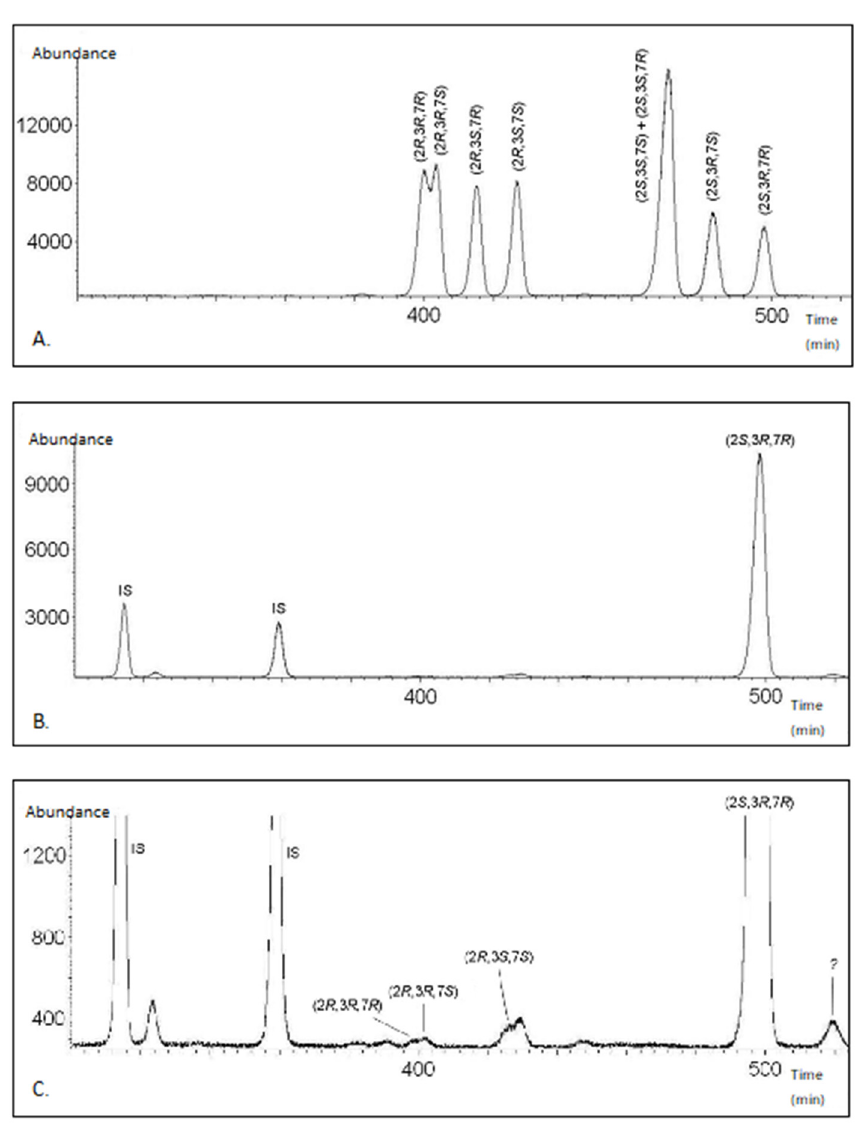
Figure 1. ( A ) GC–MS chromatogram of a reference sample of all the stereoisomers of 3,7- dimethylpentadecan-2-ol after derivatisation with ( S )-2-acetoxypropanoyl chloride. ( B ) GC–MS chromatogram of the purified extract of Diprion similis females after derivatisation with ( S )-2-acetoxypropanoyl chloride. IS = Internal Standard (pentadecan-2-ol). ( C ) Enlargement of